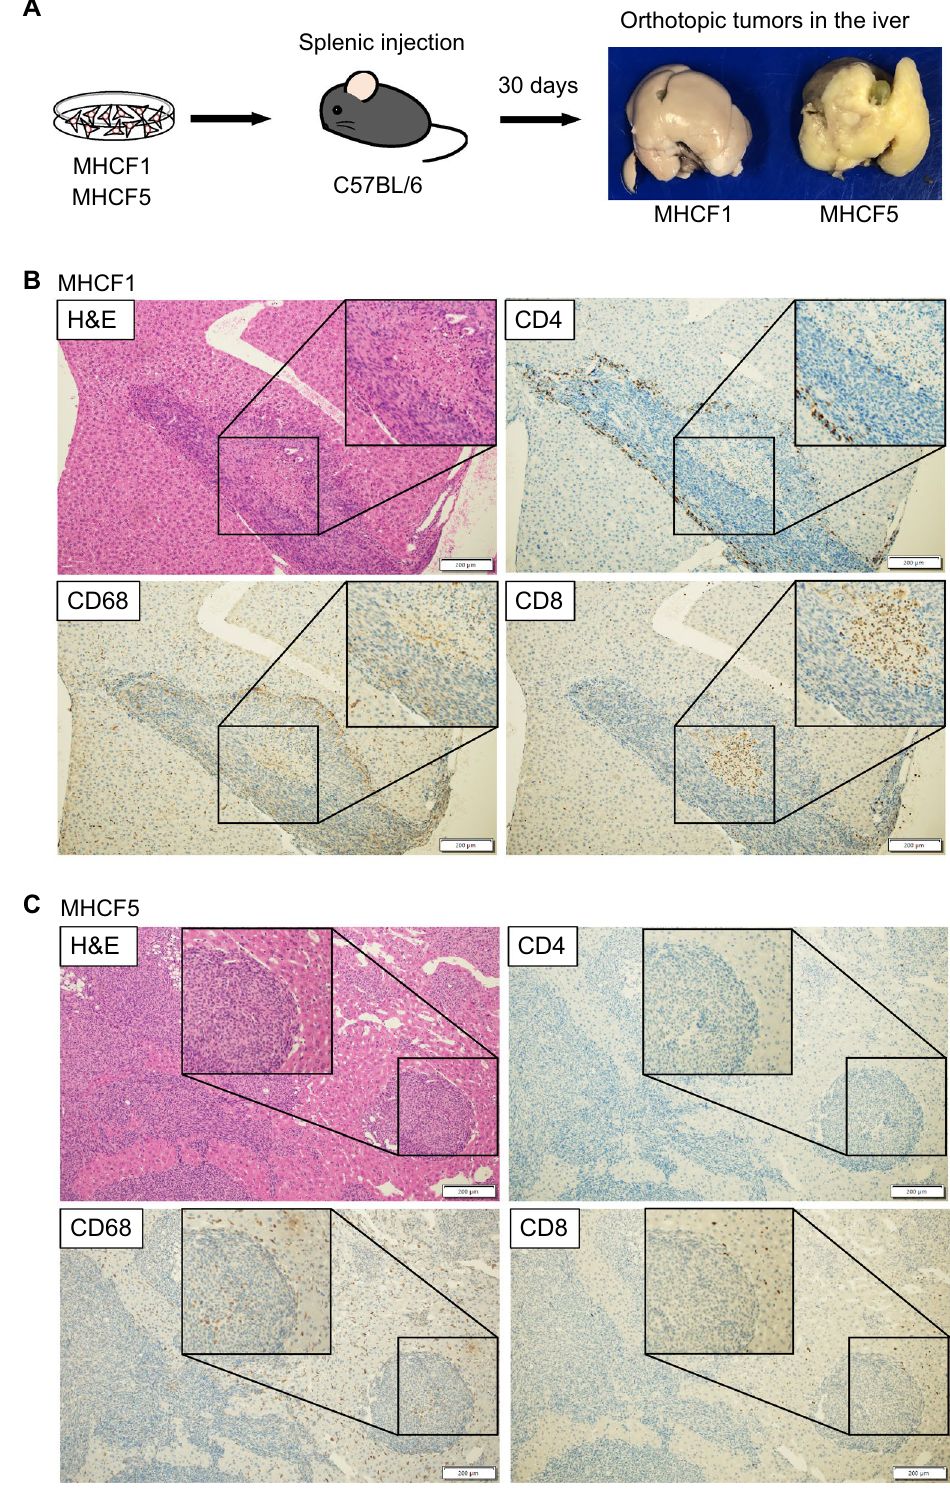
Figure 4. Establishment of orthotopic liver tumor models of MHCF1 and MHCF5 cells by splenic tumor cell injection. ( A ) Experimental procedure and development of orthotopic liver tumors of MHCF1 and MHCF5 cells. ( B ) Hematoxylin and eosin staining of a liver section, and immunohistochemical staining of immune cells in an orthotopic tumor derived from MHCF1 cells. ( C ) Hematoxylin and eosin staining of a liver section, and immunohistochemical staining of immune cells in an orthotopic tumor derived from MHCF5